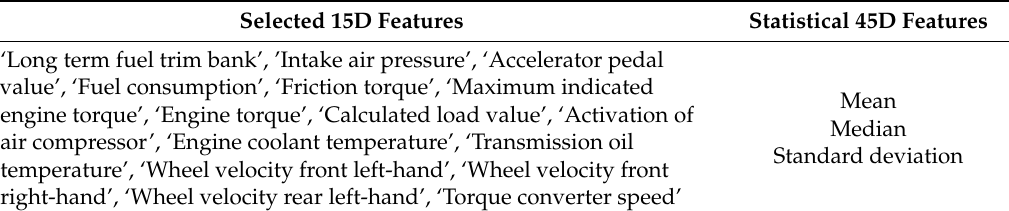
Table 1. Selected original features and statistical